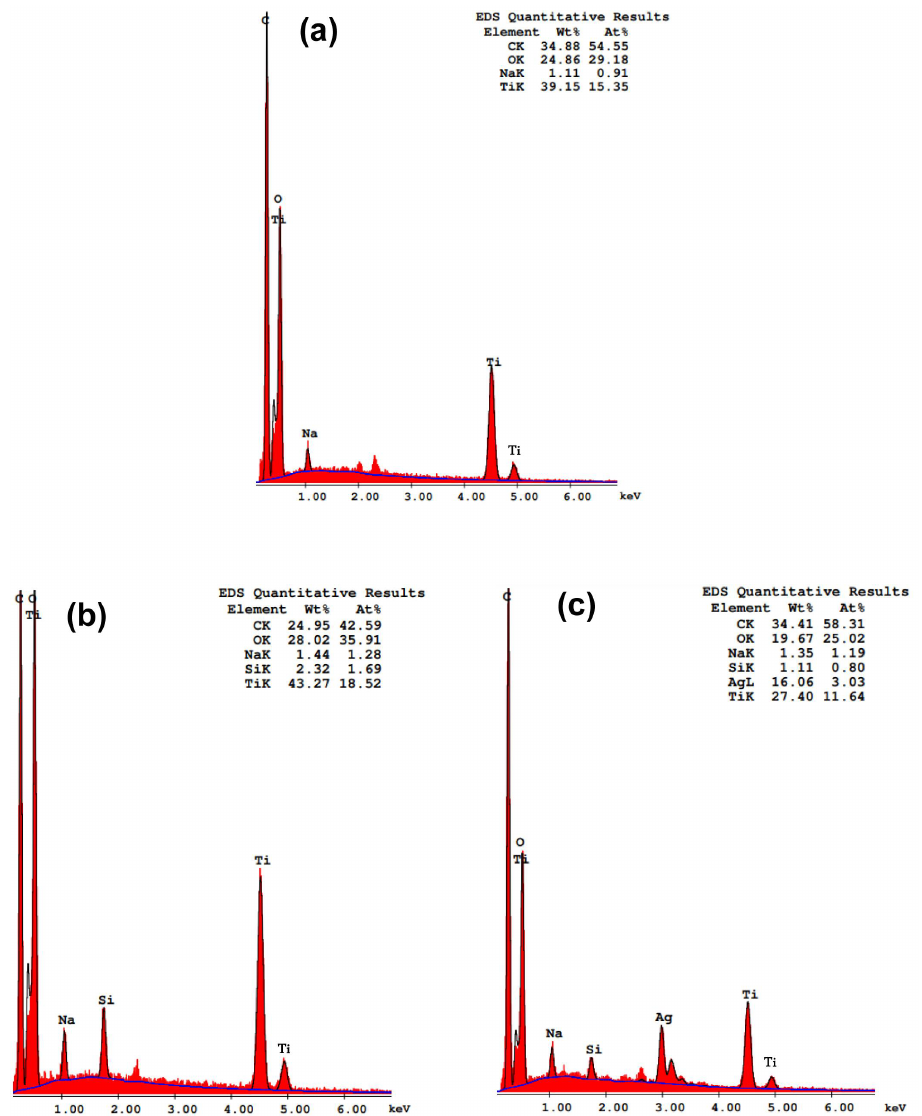
Figure 4. EDX analysis of ( a ) TiO 2 NPs, ( b ) TiO 2 /SiO 2 , and ( c ) TiO 2 /Ag.